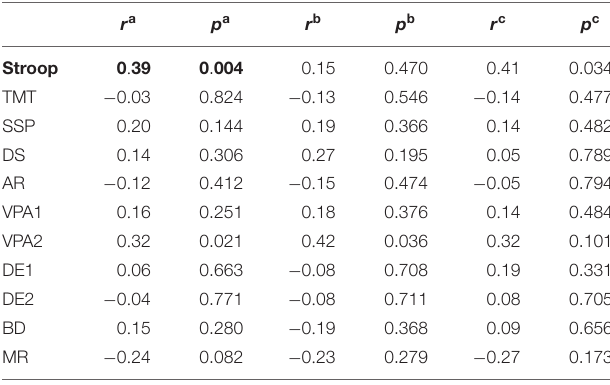
TABLE 3 | Pearson’s correlations between the rIFC volume and cognitive performance changes ( N = 53).